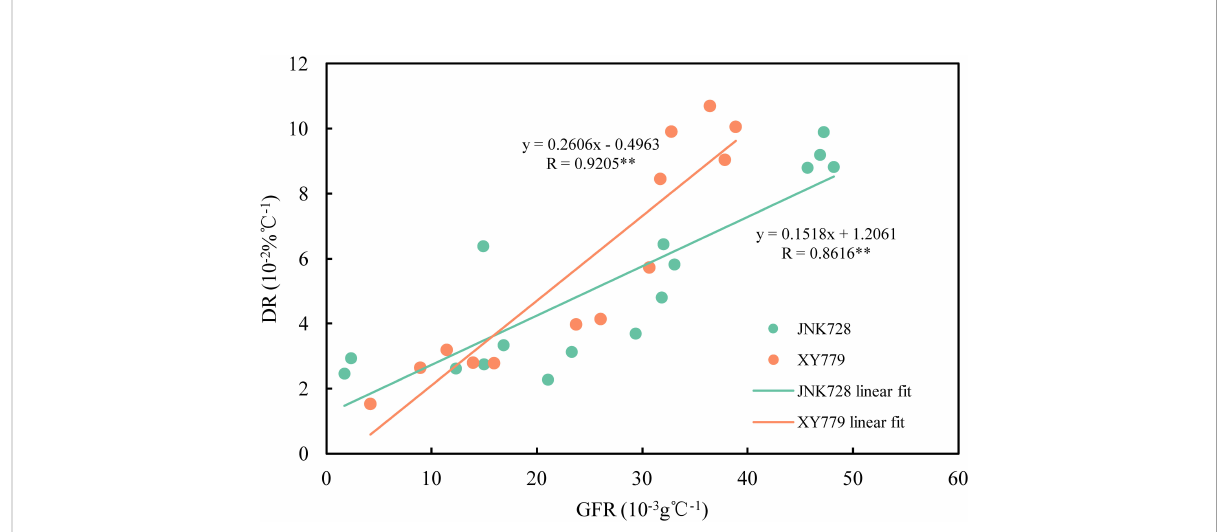
FIGURE 11 Relationship between grain fi lling rates (GFR) and dehydration rates (DR) of JNK728 and XY779 at the grain fi lling stage in 2021 and 2022. The double asterisk “ ** ” indicates signi fi cance at the 0.01 probability